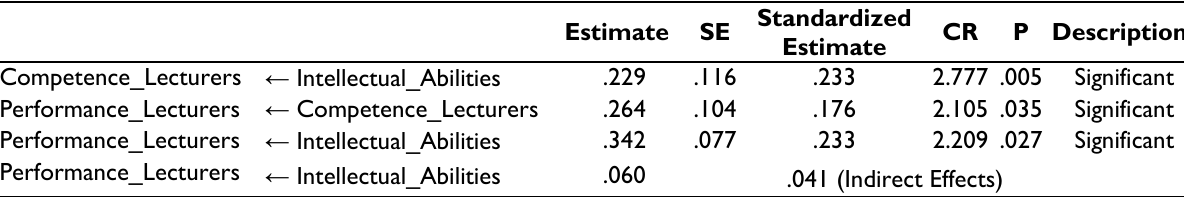
Table 3. Standardized Regression